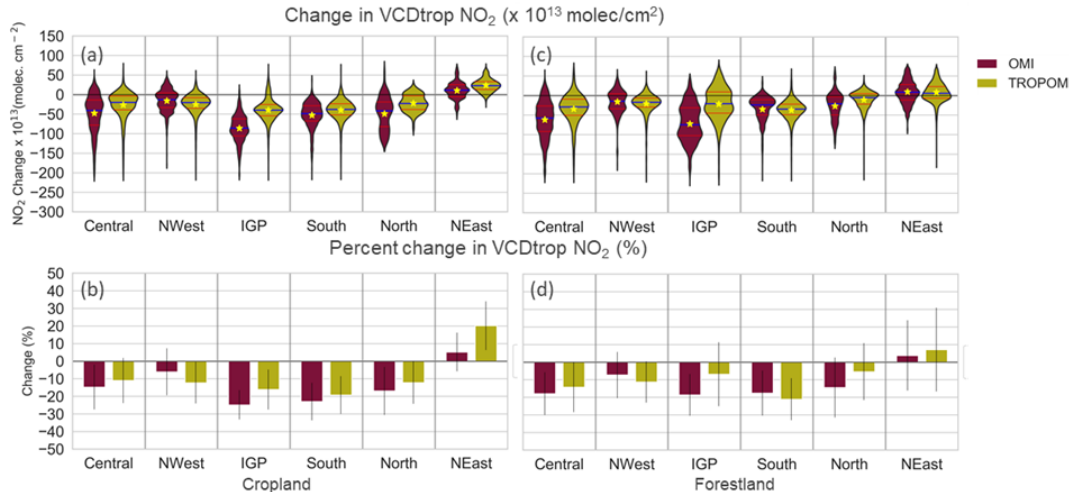
Figure 5. Observed change in VCD trop NO 2 between LDN and BAU from OMI and TROPOMI for different regions shown as (a) a violin plot of the absolute change over cropland, (b) the percentage change over cropland, (c) a violin plot of the absolute change over forestland, and (d) the percentage change over forestland. A violin plot is a combination of a box plot and a kernel density estimation (KDE) plot. KDE is a non-parametric way to estimate the probability density function (PDF). The red lines in the violin plot show the interquartile range; the blue line shows the median value; the yellow star shows the mean value. The vertical lines in the bar plot show the standard deviation. The abbreviations NWest and NEast are for north-west and north-east regions, respectively.